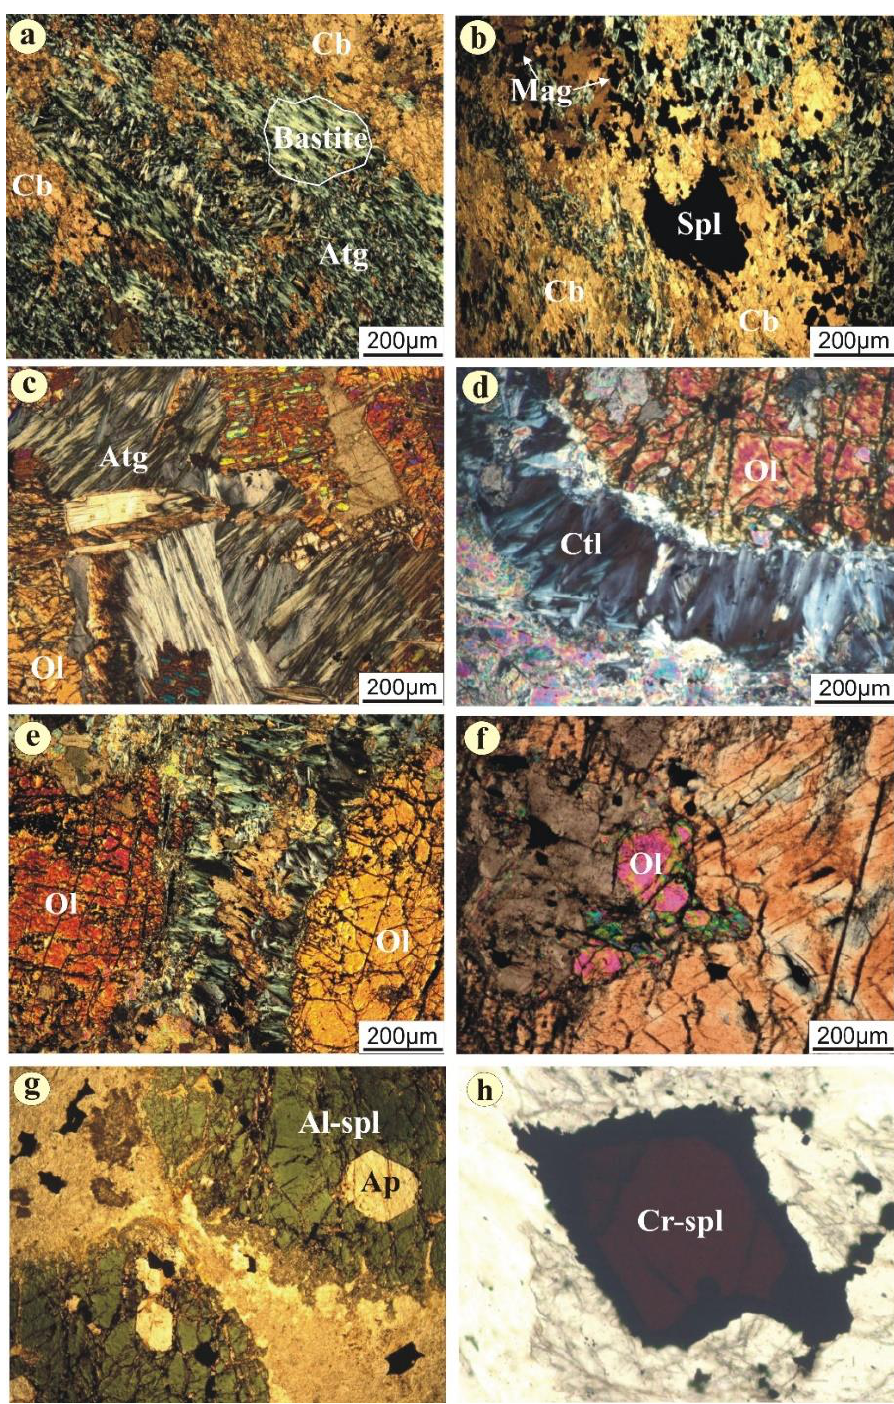
Figure 3. Photomicrographs of serpentinites—( a ) sherds of antigorite (Atg) forming a bastite texture after pyroxene; ( b ) patches of carbonates (Cb) associated with disseminated magnetite (Mag)— and serpentinized peridotites: ( c ) fibro-lamellar antigorite enclosed between olivine (Ol) crystals; ( d ) perfect veinlet of chrysotile (Ctl); ( e ) replacement of olivine by antigorite; ( f ) schiller structure of orthopyroxene (Opx); ( g ) two porphyroblasts of green spinel (Al-Spl) engulfing apatite (Ap); and ( h ) fresh core of Cr-spinel (Cr-Spl) rimmed by secondary Cr-magnetite (Cr-Mag). On the other hand, serpentinized peridotites are essentially composed of serpentines (antigorite and chrysotile) with variable relics of orthopyroxene, clinopyroxene,